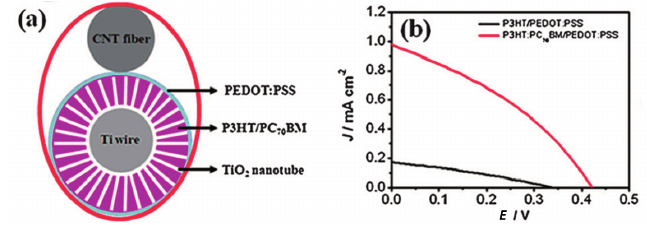
Figure 13. A CNT (carbon nanotube) fiber-based OPV: ( a ) schematic illustration; ( b ) J – V curves, respectively. Cited from [105]. Copyright 2012, The Royal Society of